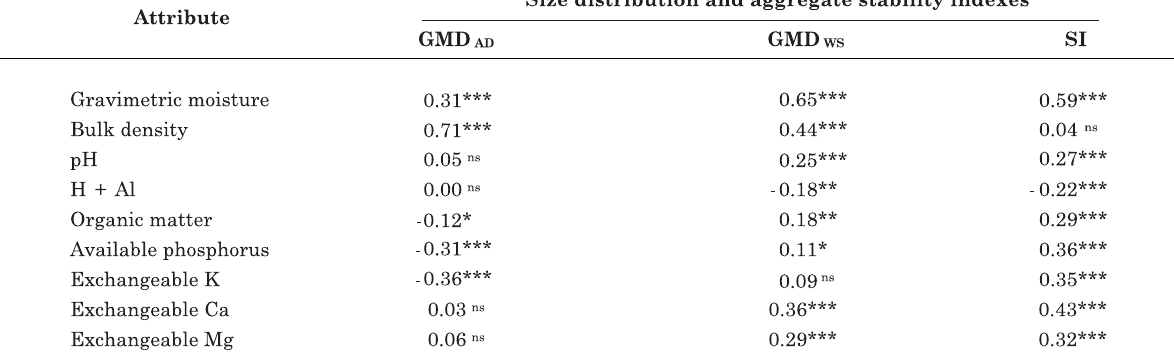
Table 3. Pearson correlation coefficients between size distribution and aggregate stability indexes with physical and chemical properties determined in four layers, after nine years under five tillage systems and five nutrient sources